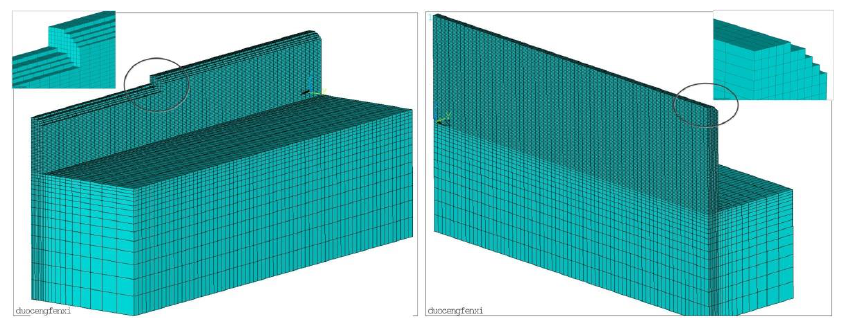
Figure 4. Finite element meshing model.